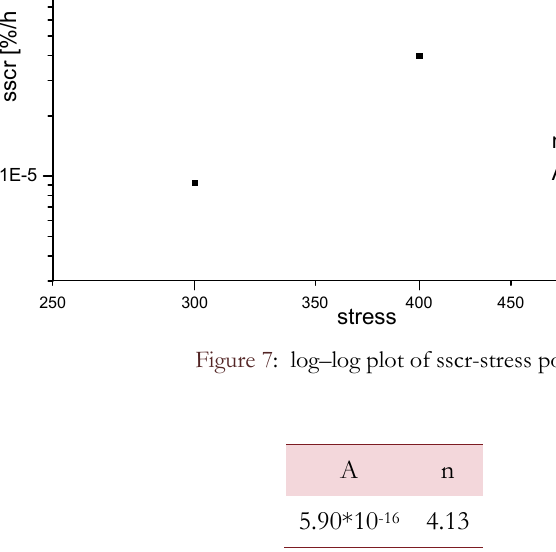
Table 3: Values of Norton-power law